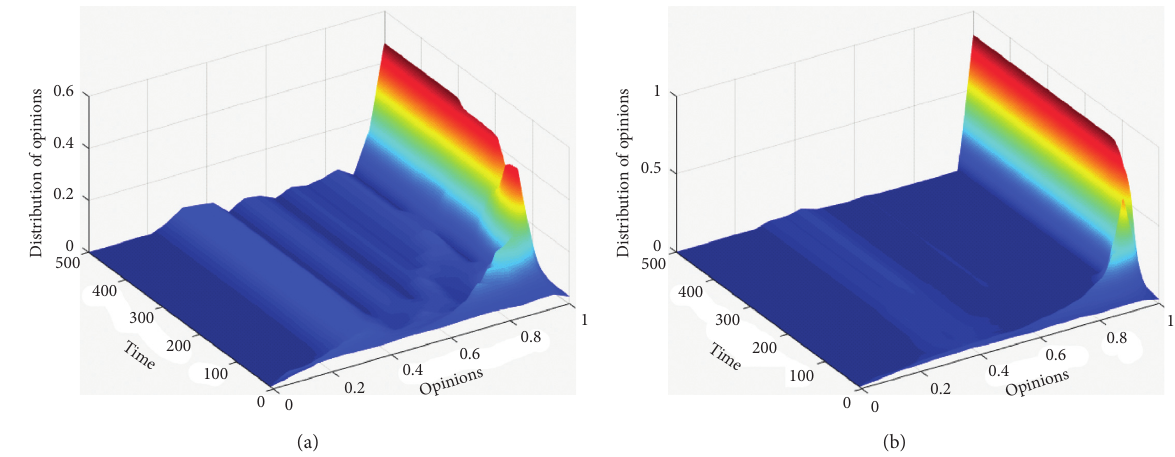
Figure 8: Group opinion distribution evolution in the small-world network. Group polarization is formed when d (b) d m � 0 . 52.